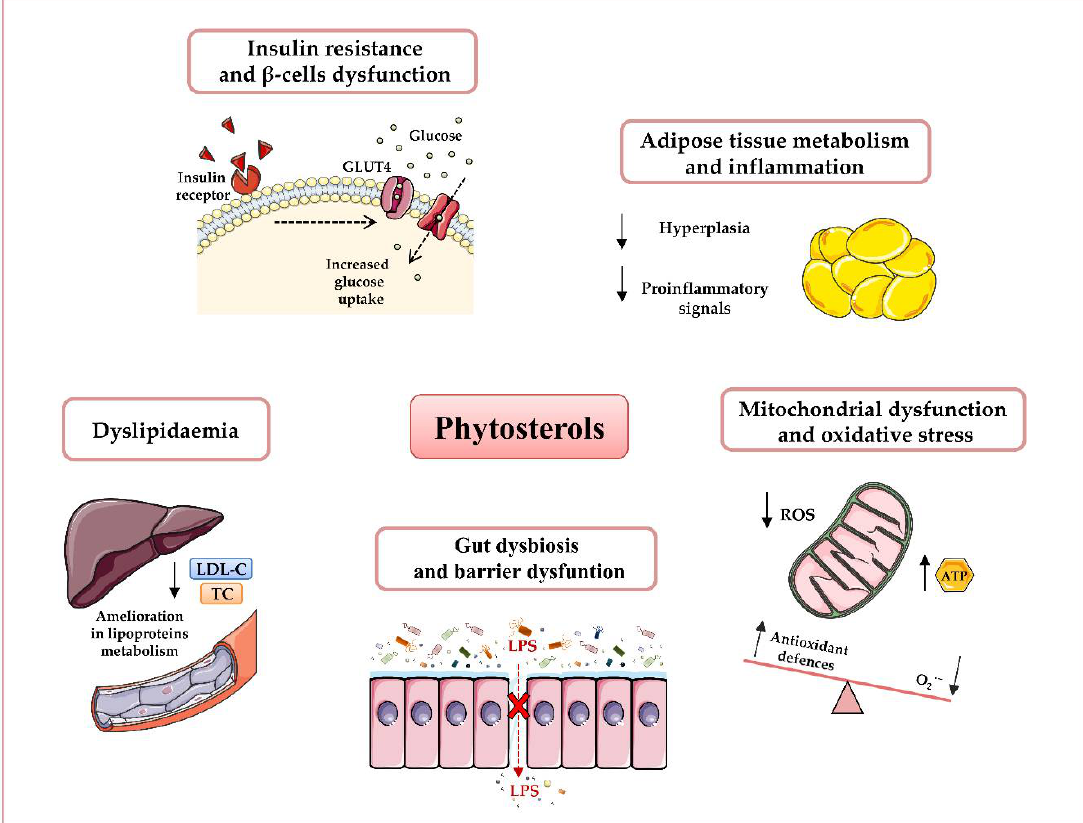
Figure 1. Potential beneficial effects of phytosterols in obesity and type 2 diabetes T2D prevention and therapy. Plant sterols have been shown to reduce dyslipidaemia, insulin resistance, and β-cells’ dysfunction, attenuate adipose inflammatory signalling, enhance mitochondrial ATP content, and decrease oxidative stress, as well as ameliorate gut microbiota dysbiosis and barrier dysfunction. Abbreviations: Adenosine triphosphate (ATP), Glucose transporter type 4 (GLUT4), Low-density lipoprotein-Cholesterol (LDL-C), Lipopolysaccharide (LPS), Reactive oxygen species (ROS), Total Cholesterol (TC).